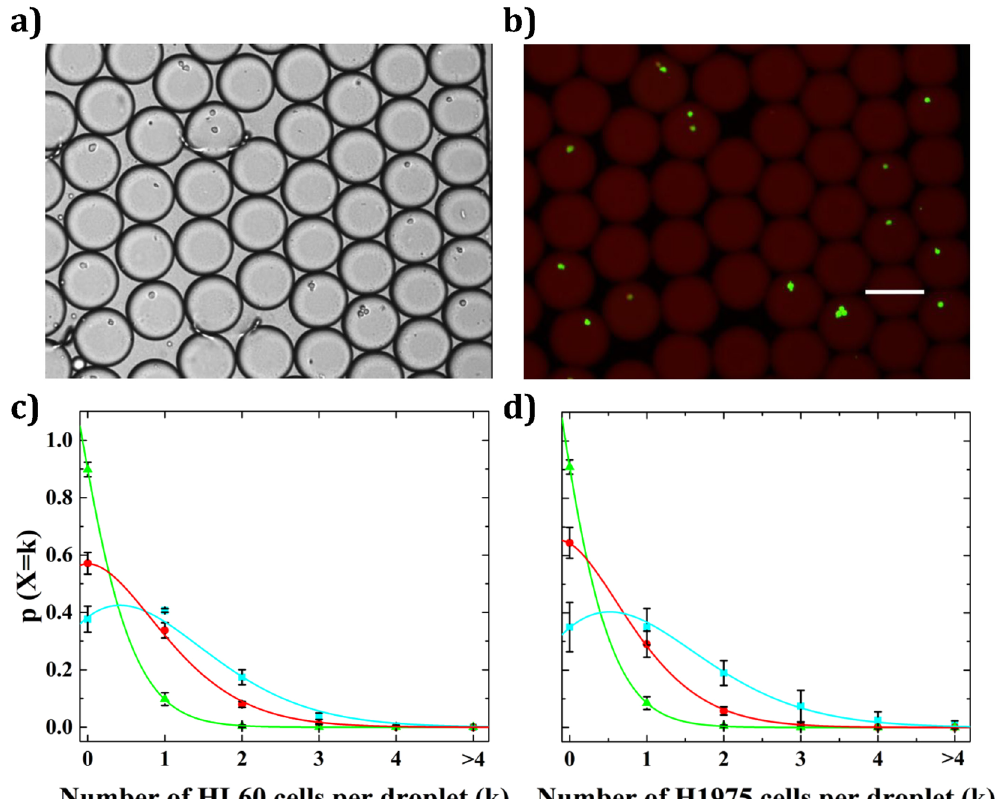
Figure 3. Counting of human cells. Bright field image (a) and fluorescence image (b) of HL60 cells encapsulated in droplets. Droplets were labeled by adding the soluble dye Sulforhodamine-B in the aqueous phase. Scale bar: 100 µ m. (c) Distribution of HL60 cells in droplets (mean ± s.d for n = 3; Poisson fit is plotted as a straight line). Green triangles. Cell density was adjusted to 2 × 10 5 cells/mL such that expected theoretical cell to droplet ratio ( λ theo ) is λ theo = 0.1 (given that droplet’s volume is 500 pL). Cell distribution fitted λ = 0.1 ± (7.4 × 10 − 4 ) with R 2 = 0.99. Red circles. Cell density was adjusted to 10 6 cells/mL such that λ fit Cell distribution fitted λ fit = 0.56 ± 0.01 with R 2 = 0.99. Blue squares. Cell density was adjusted to 2 × 10 6 cells/ mL such that λ theo = 1. Cell distribution fitted λ fit = 0.96 ± 0.01 with R 2 = 0.98. (d) Distribution of H1975 cells in droplets (mean ± s.d for n = 3; Poisson fit is plotted as a straight line). Green triangles. Cell density was adjusted to 2 × 10 5 cells/mL such that λ theo = 0.1. Cell distribution fitted λ fit = 0.1 ± 0.006 with R 2 = 0.99. Red circles. Cell density was adjusted to 10 6 cells/mL such that λ theo = 0.5. Cell distribution fitted λ fit = 0.44 ± 0.006 with R 2 = 0.99. Blue squares. Cell density was adjusted to 2 × 10 6 cells/mL such that λ theo = 1. Cell distribution fitted λ = 1 ± 0.02 with R 2 = fit